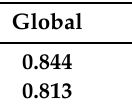
Table 5. Weighted Pearson correlation coefficients (power fit) obtained for the maximum variable throughout the cycle, R M , for GLT = 80, constitutive model IsoH and using C3D4 elements. The predic- S tors analysed are: the fluctuation of stresses ( σ f ) and the absolute maximum principal stress (AMP σ ). Values higher than 0.8 are highlighted in boldface.